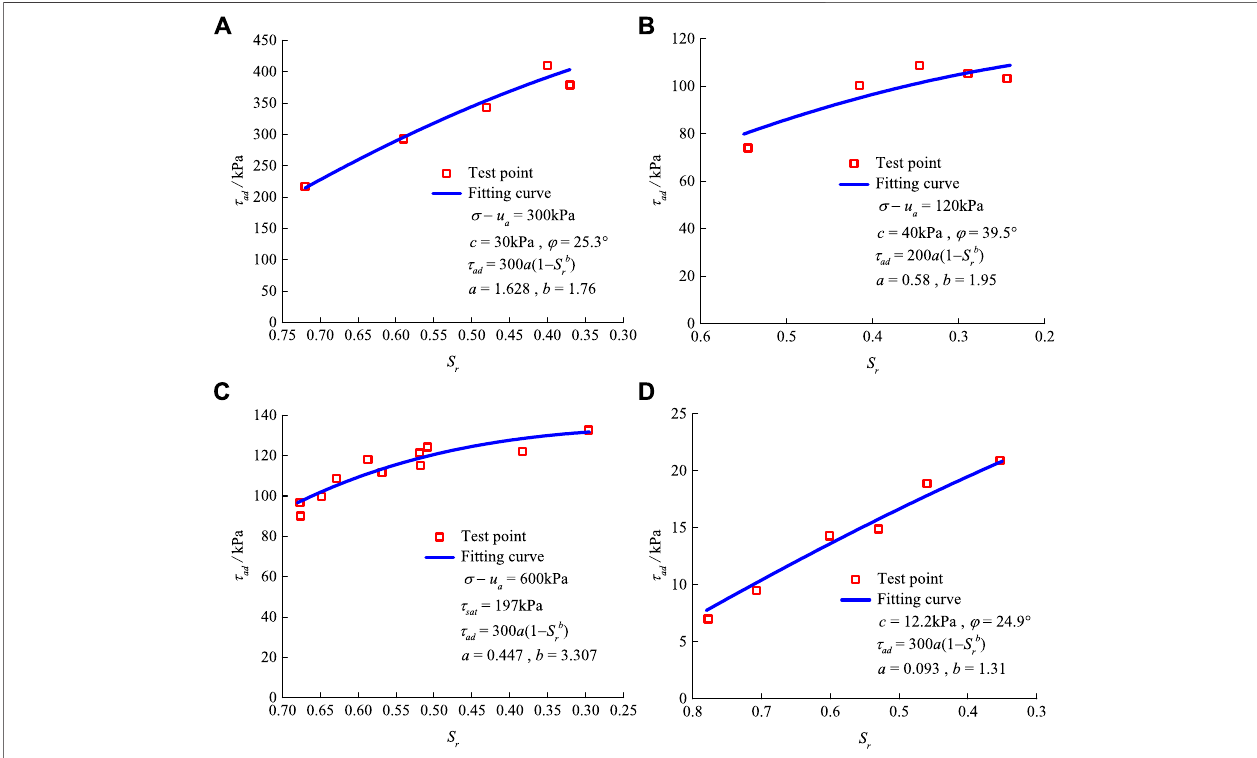
FIGURE 1 | Data fi tting of different clays: (A) Madrid clay (Escario and Saez, 1986), (B) Madrid sandy clay (Escario and Saez, 1986), (C) kaolin clay (Tarantino and Tombolato, 2005), and (D) silty clay (Shen et al., 2007).